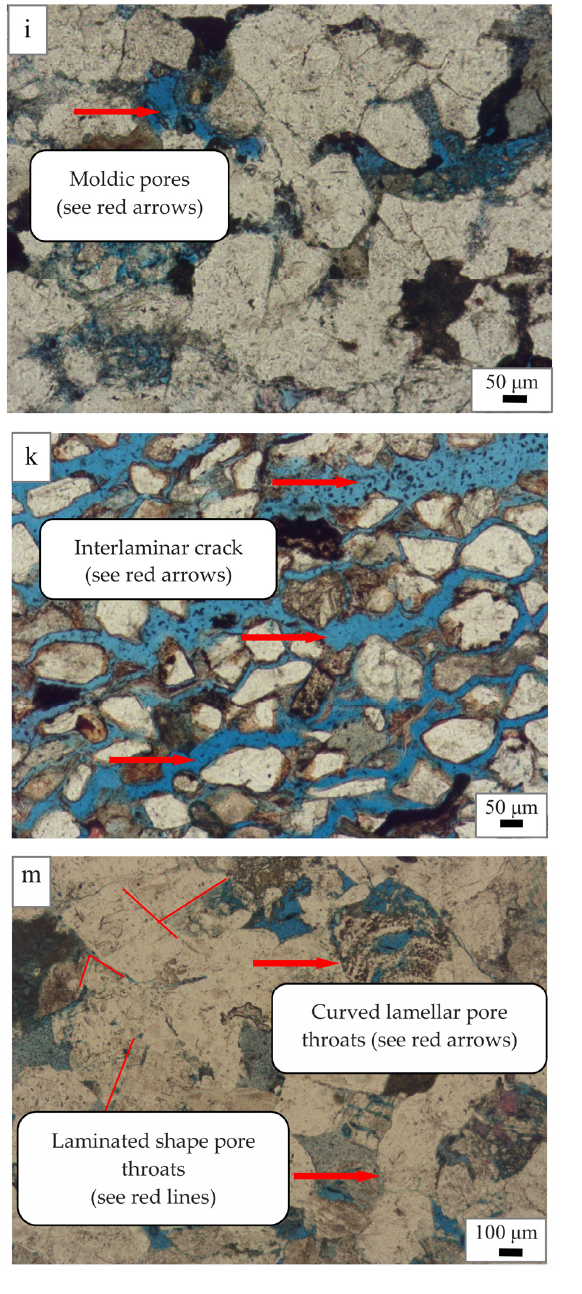
Figure 5. The types of pores and pore throats in the deep-mine sandstone: ( a ) Jurassic sandstone, plane polarized light (PPL). ( b ) Permian sandstone, PPL. ( c ) Jurassic sandstone, SEM. ( d ) Permian sandstone, SEM. ( e ) Permian sandstones, PPL. ( f ) Permian sandstone, PPL. ( g ) Permian sandstone, PPL. ( h ) Permian sandstone, PPL. ( i ) Permian sandstone, PPL. ( j ) Permian sandstone, SEM. ( k ) Jurassic sandstone, PPL. ( l ) Permian sandstone, PPL. ( m ) Permian sandstone, PPL. ( n ) Jurassic sandstone, PPL.